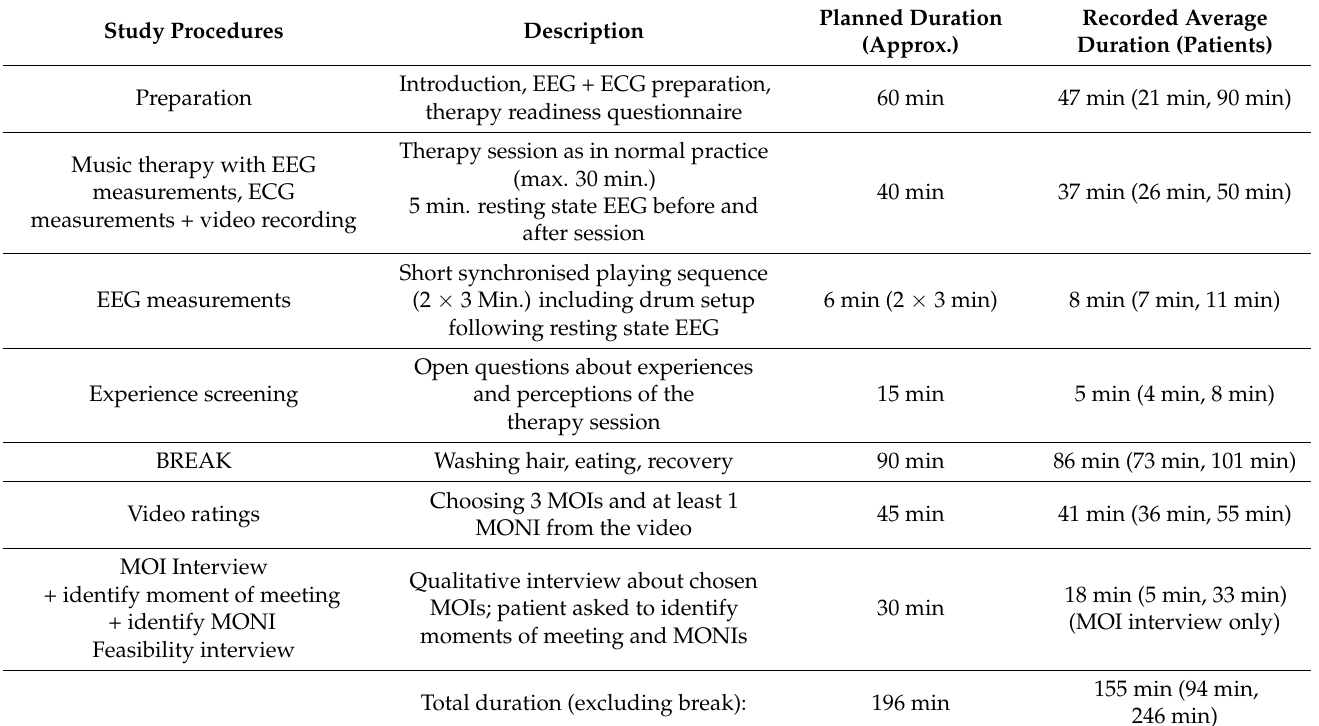
Table 1. Planned and actual duration of study